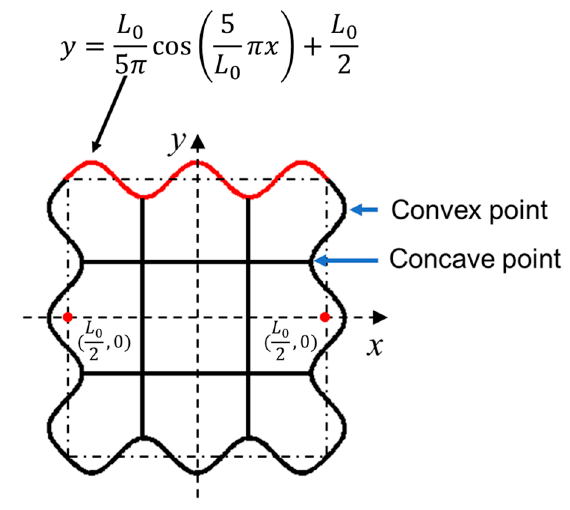
Figure 1. Cross-sectional configuration of the MCCT.